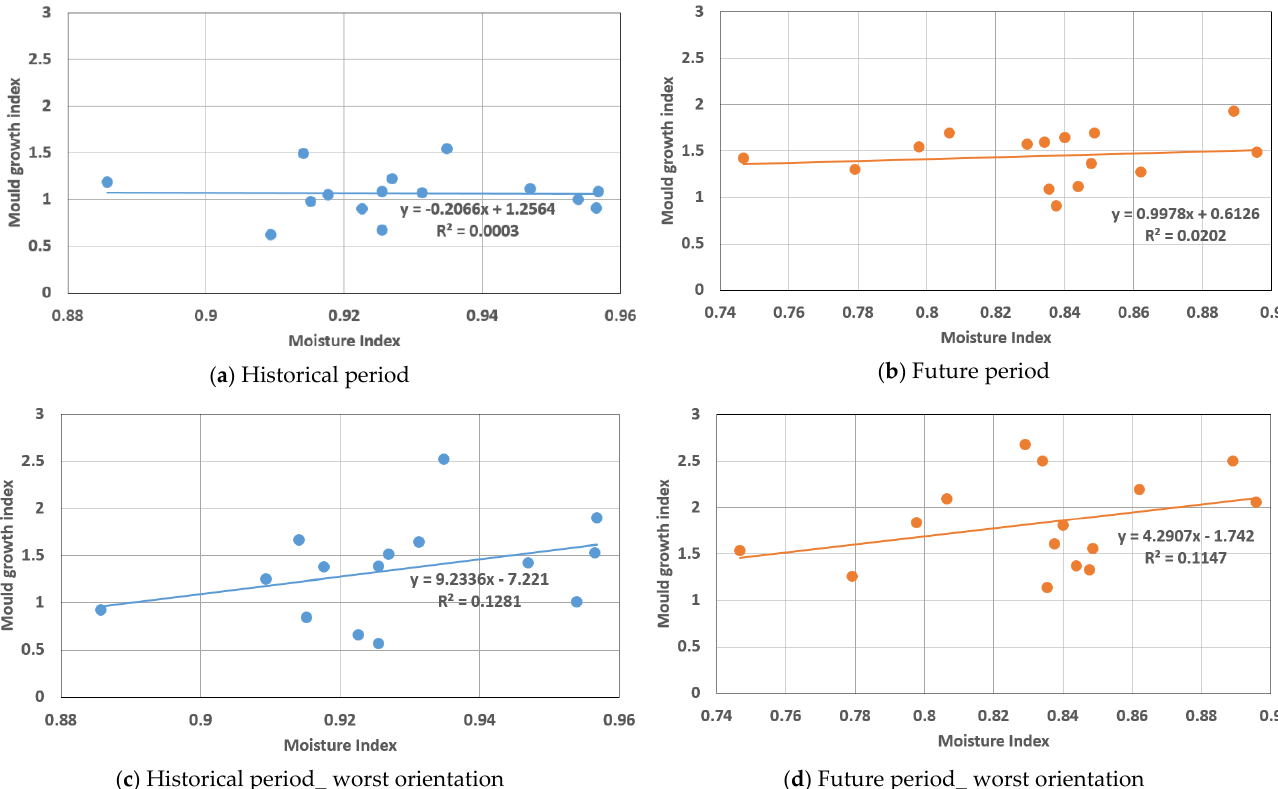
Figure 13. Mould growth index (2-year’s average) of 15 climatic realisations using 2560 runs.